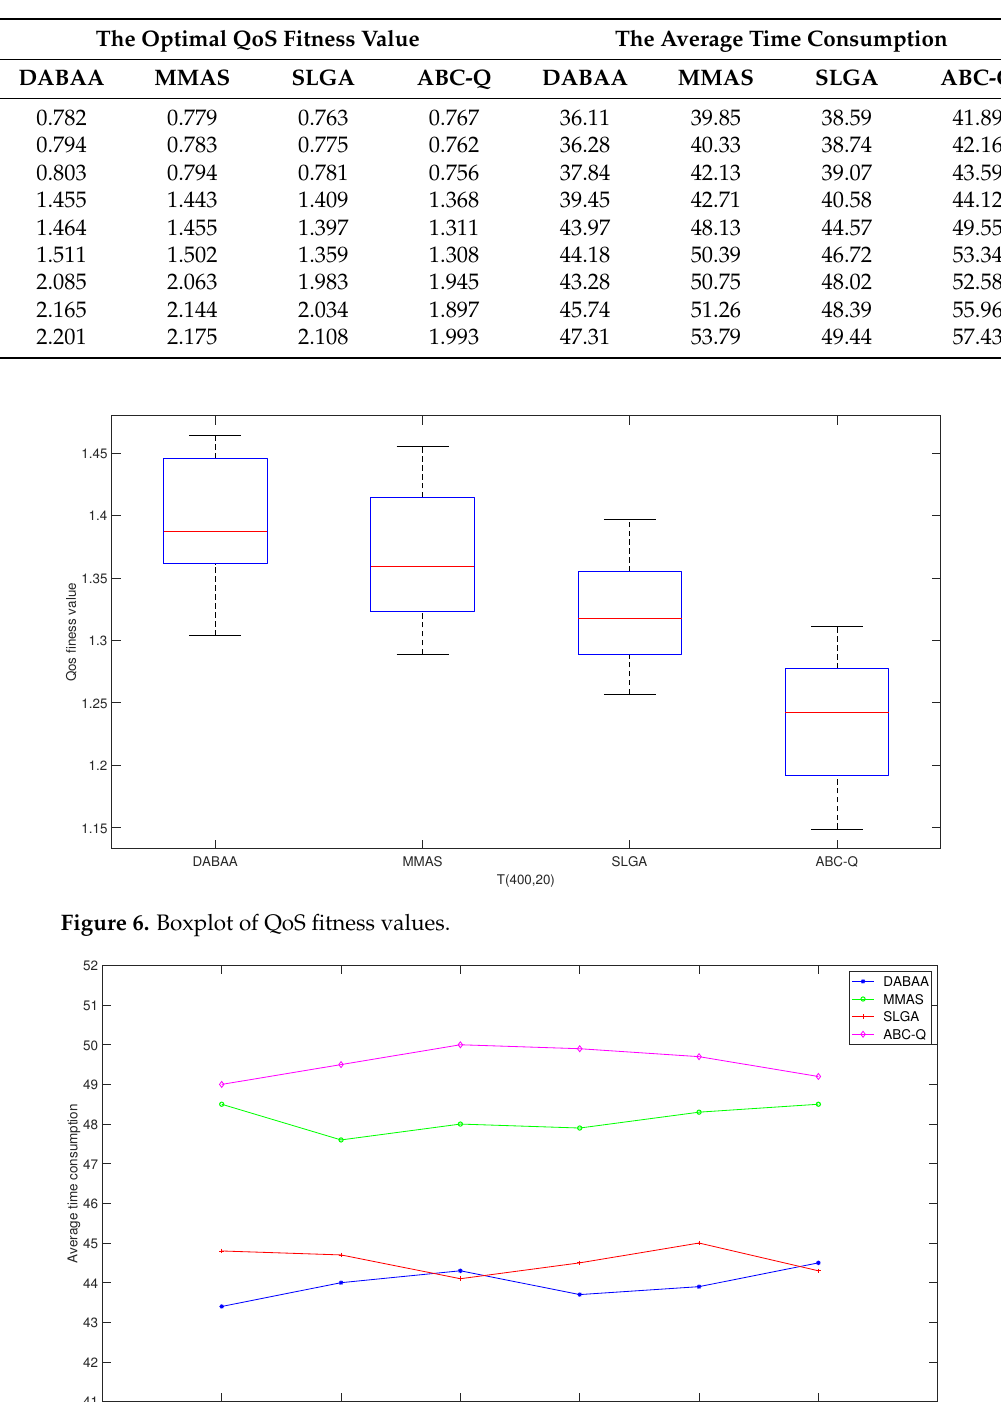
Table 7. Statistics of the running results of the four algorithms.